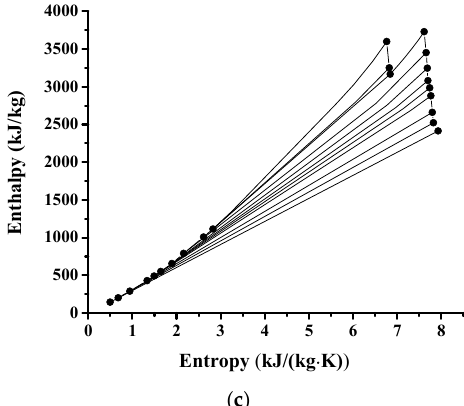
Figure 3. Steam turbine expansion lines on the Mollier diagram of all loads. ( a ) High load; ( b ) Medium load; ( c ) Low load.